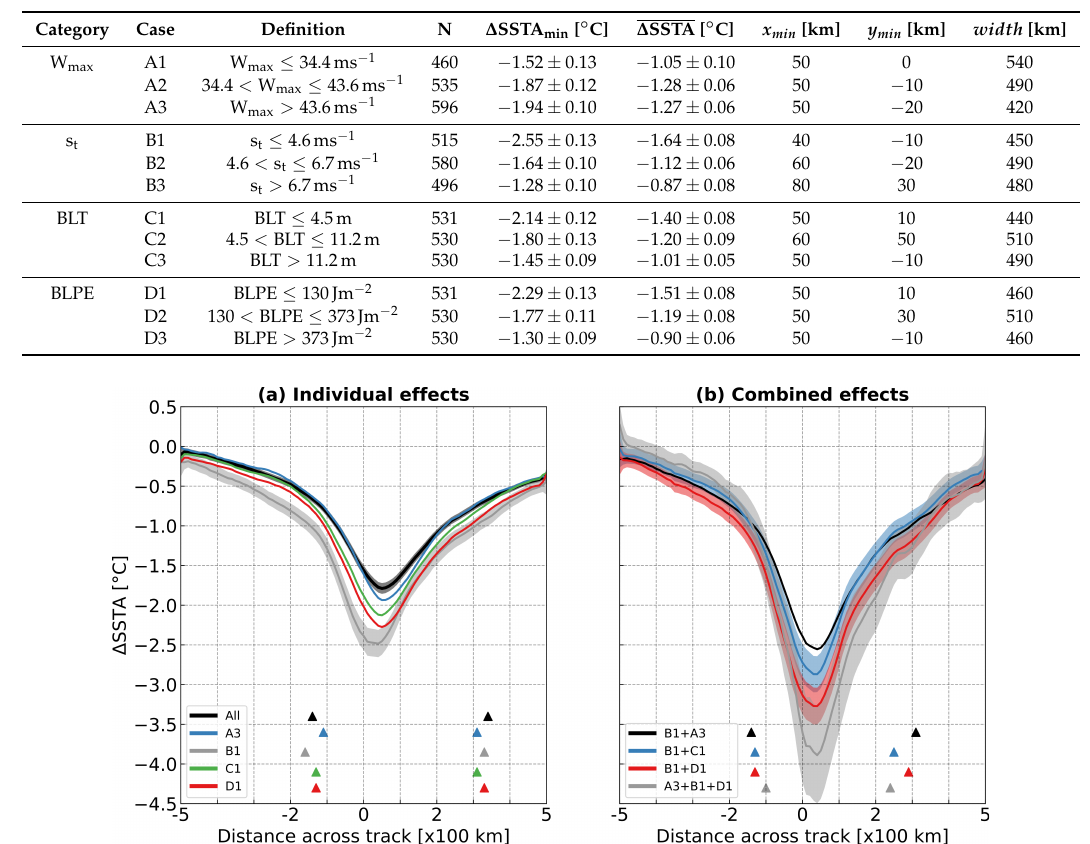
Figure 8. ( a ) Cross-sections in the perpendicular direction with respect to the hurricane movement at y = 0 of mean composites of ∆ SSTA obtained from the merged SST dataset for all selected cases: A3, B1, C1, D1 (Table 2). ( b ) Same as ( a ) but for the following selected combinations: B1+A3, B1+C1, B1+D1 and A3+B1+D1 (Table 3). Shading indicates the margin of error of ∆